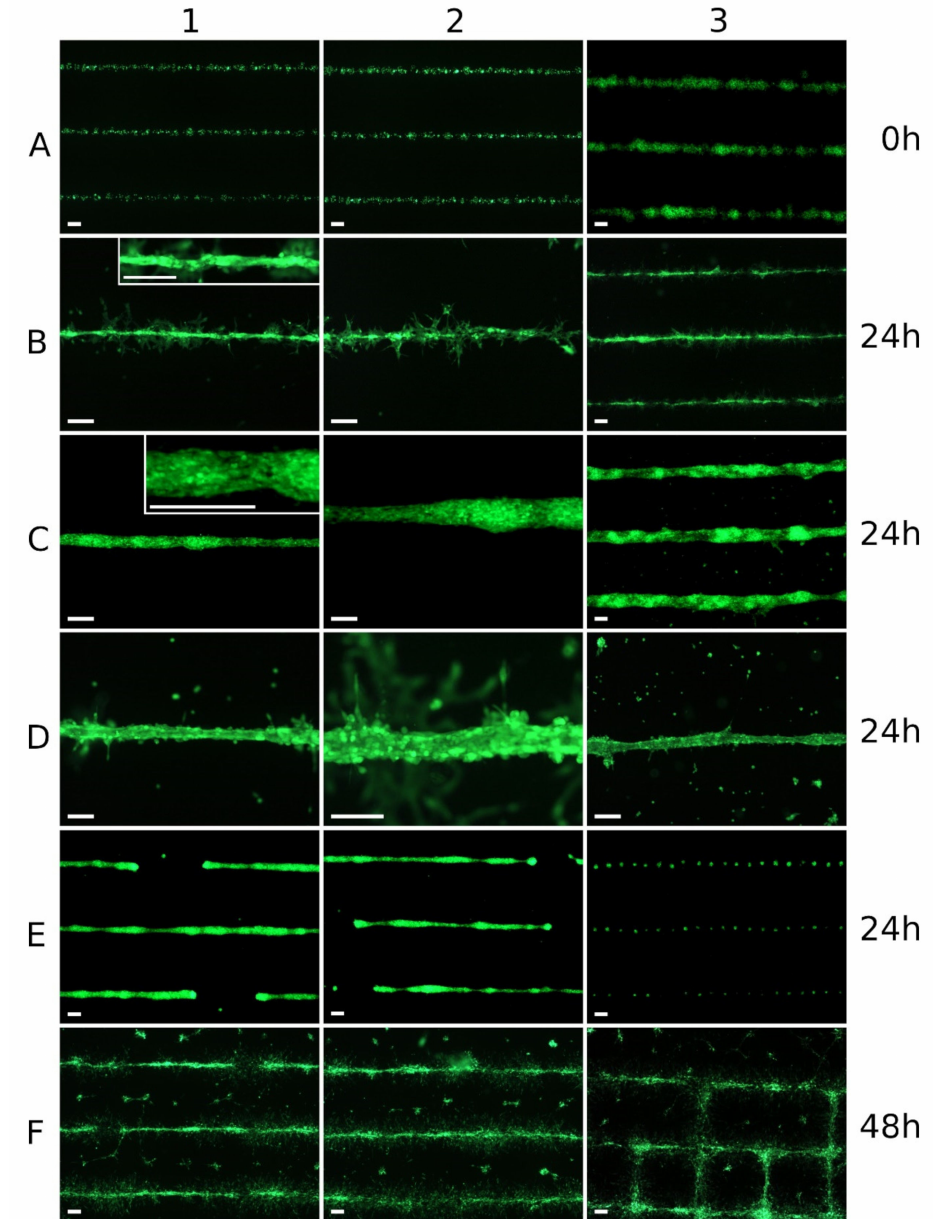
Figure 3. Vessel formation was not always successful. Green fluorescent endothelial cells (HPMECs, GFP-labeled) printed in thinner and thicker lines on Matrigel. Images were taken immediately (line A ), 24 h ( B – E ), or 48 h ( F ) after printing. Despite very similar appearance of the printing results immediately after printing, the patterns may look very different after 24 h. Examples of thinner lines (line B ) and thicker lines (lines C and D ) are shown after 24 h, where continuous tubular structures have formed entirely ( B1 , C1 , C2 , C3 ) or partially ( B3 ). In B3 , the cells have formed partial aggregates but no vascular structures; in line D they are only gutter-shaped structures that are open at the top. In line E , after 24 h, larger cell-free interruptions can appear, although directly after printing there was a continuous line; in extreme cases, the endothelial cells contract to equidistant spherical cell aggregates ( E3 ). The formation of the tubular structures was transient only; within another 1–2 days, endothelial cells began to re-dissolve the formation, migrate ( F ) and, also by proliferation, gradually colonize the entire area. Applied laser pulse energies were 6 µ J ( A1 , A2 , B , E3 , F ), 8 µ J ( A3 , C1 , D , E1 , E2 ), and 10 µ J ( C2 , C3 ); the patterns in panels ( C , D , E1 , E2 , F ) were printed twice in the same place. B1 and C1 include an integrated detail image. All scale bars are 200 µ